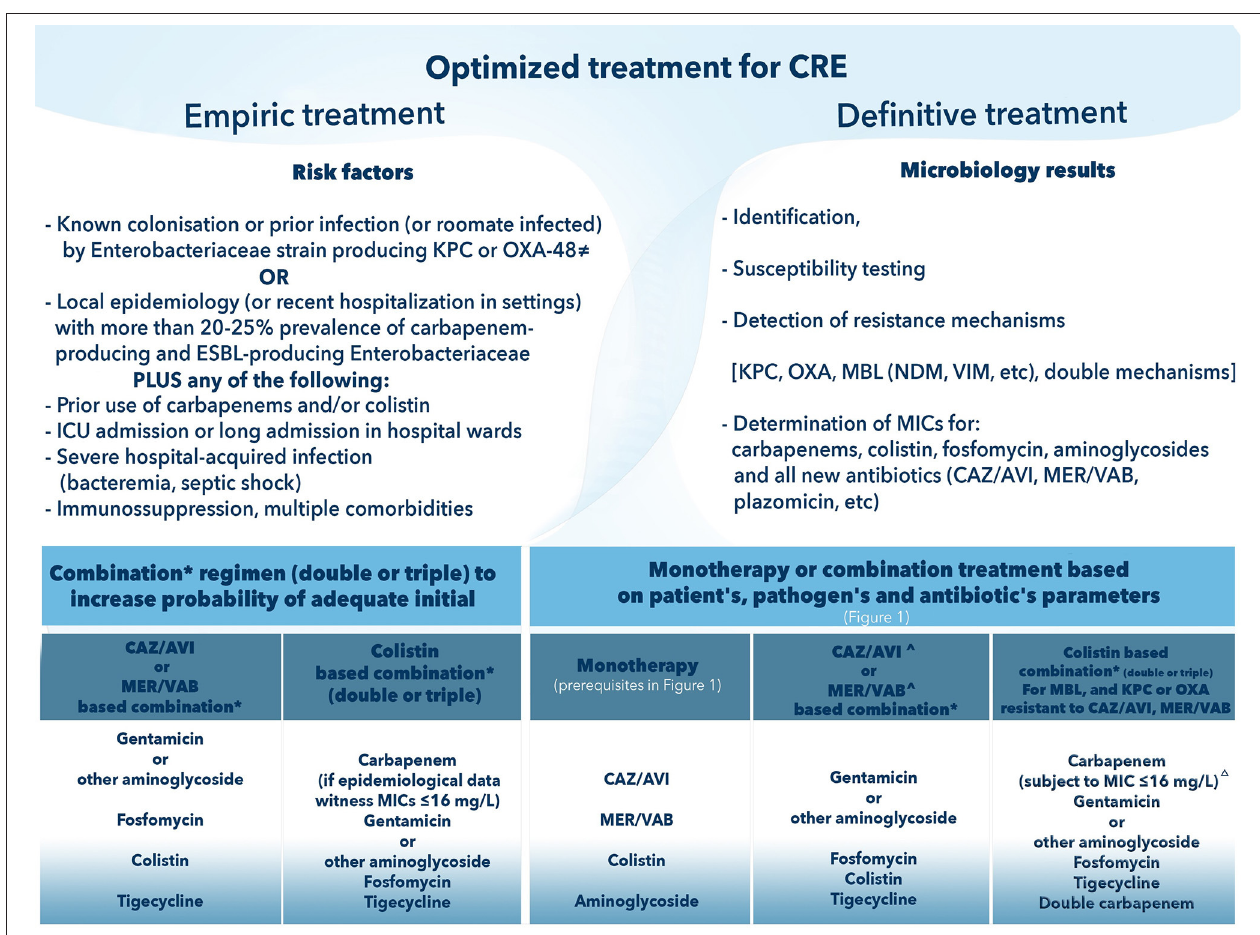
FIGURE 2 | How to optimize treatment of Carbapenem-Resistant Enterobacteriaceae (CRE). CAZ-AVI, ceftazidime avibactam; CRE, carbapenem-resistant Enterobacteriaceae; MER/VAB, meropenem vaborbactam; MIC, minimum inhibitory concentration. 6= OXA-48 is permissive only for CAZ-AVI. *Components of the combination will be based on: (i) epidemiology data (for empirical regimen); (ii) pharmacokinetic/pharmacodynamic considerations relating to the source of infection; (iii) lower MIC (if possible, avoidance of antibiotics with borderline susceptibility). ∧ Selection of CAZ-AVI or MER/VAB in definitive treatment precludes demonstrated in vitro susceptibility and absence of detected metallo-beta lactamase mechanism of resistance; for MER/VAB absence of OXA as well. 1 Higher MICs against meropenem (up to 64 mg/L) may require higher doses and therapeutic drug